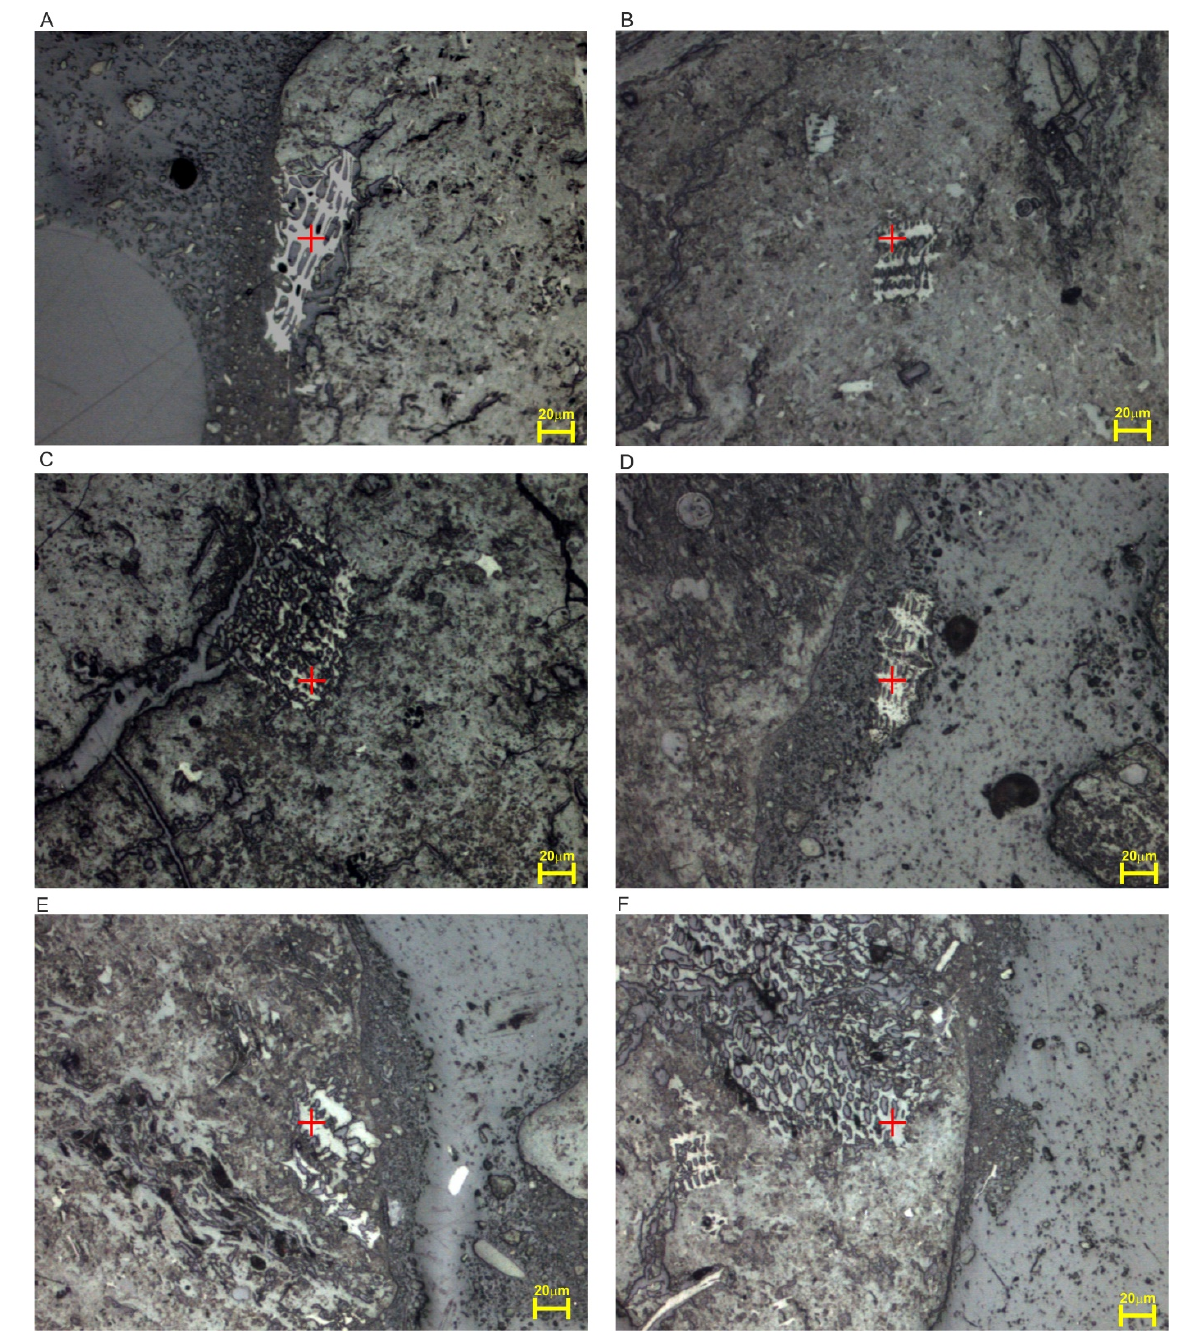
Figure A4. Selected measurement points (+) on fusinite ( A – F ).